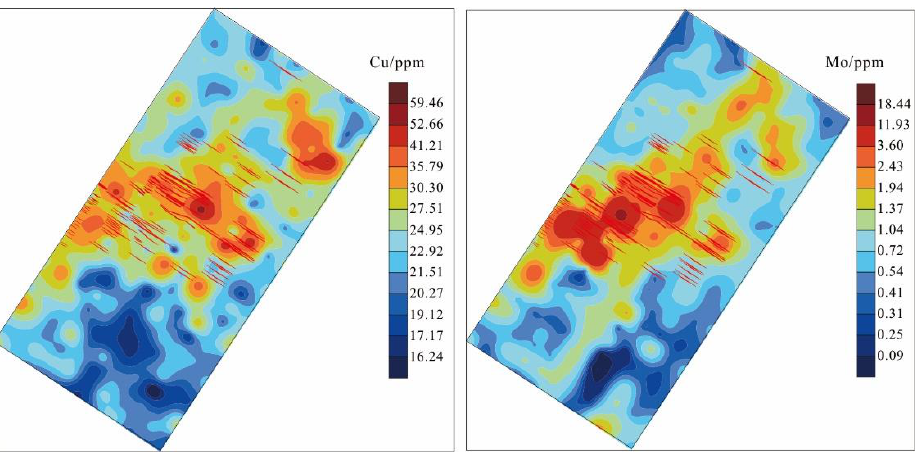
Figure 10. Geochemical map of the fine-grained soil prospecting method in Zhunsujihua Cu-Mo deposit.